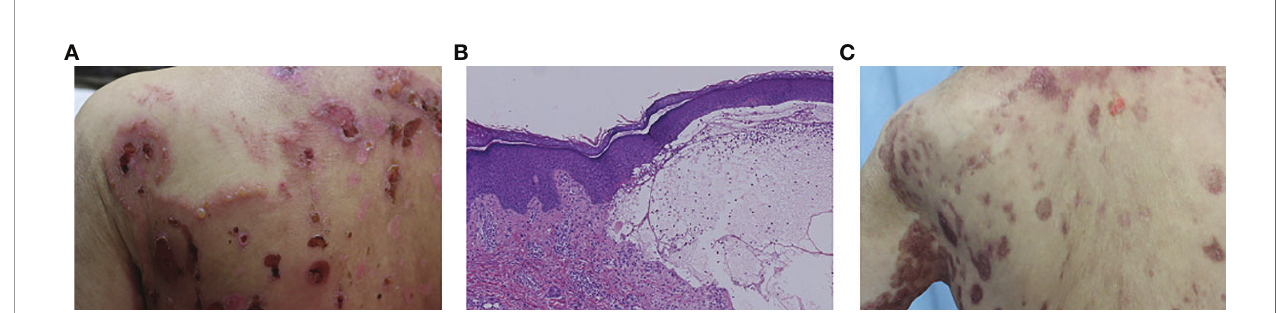
FIGURE 2 | (A) Bullae and erosions presented on the back. (B) Histology from a bulla on the right forearm showed subepidermal bulla formation and the bullous fl uid and the super fi cial dermis were in fi ltrated by eosinophils. (C) The bullous eruptions were stable 2 months